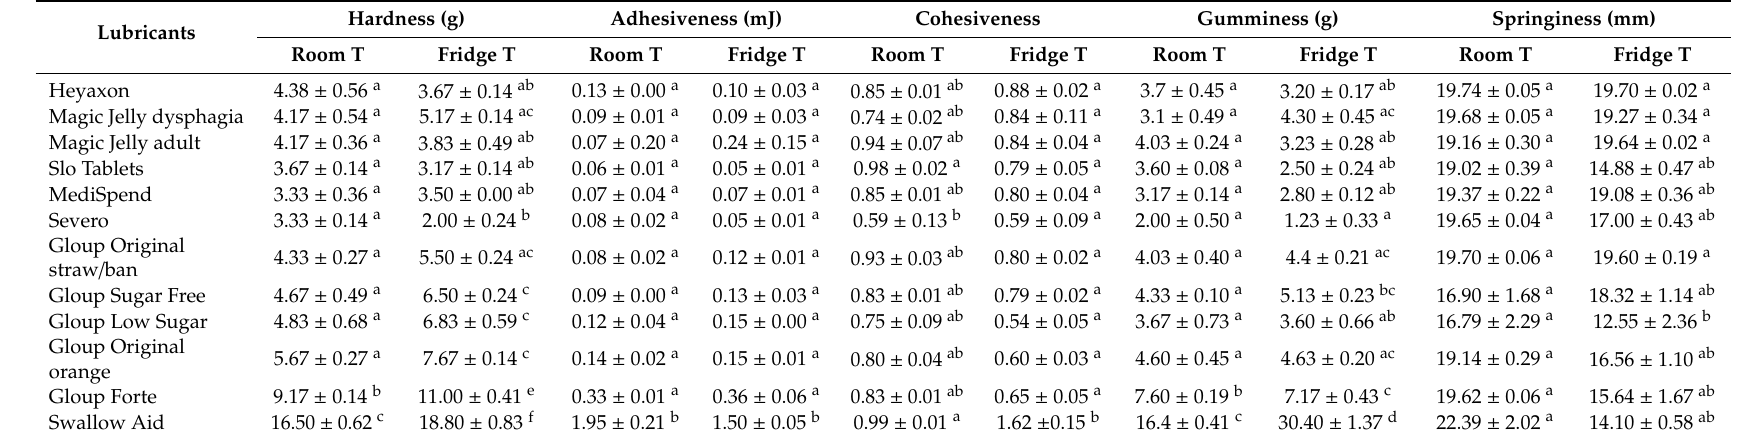
Table 5. Texture profile analysis of the medication lubricants measured at room (24 ◦ C) and fridge temperature (4 ◦ C). Mean values followed by unlike superscript letters (a–f) within a column are significantly di ff erent ( p < 0.05). The data are mean ± se for three